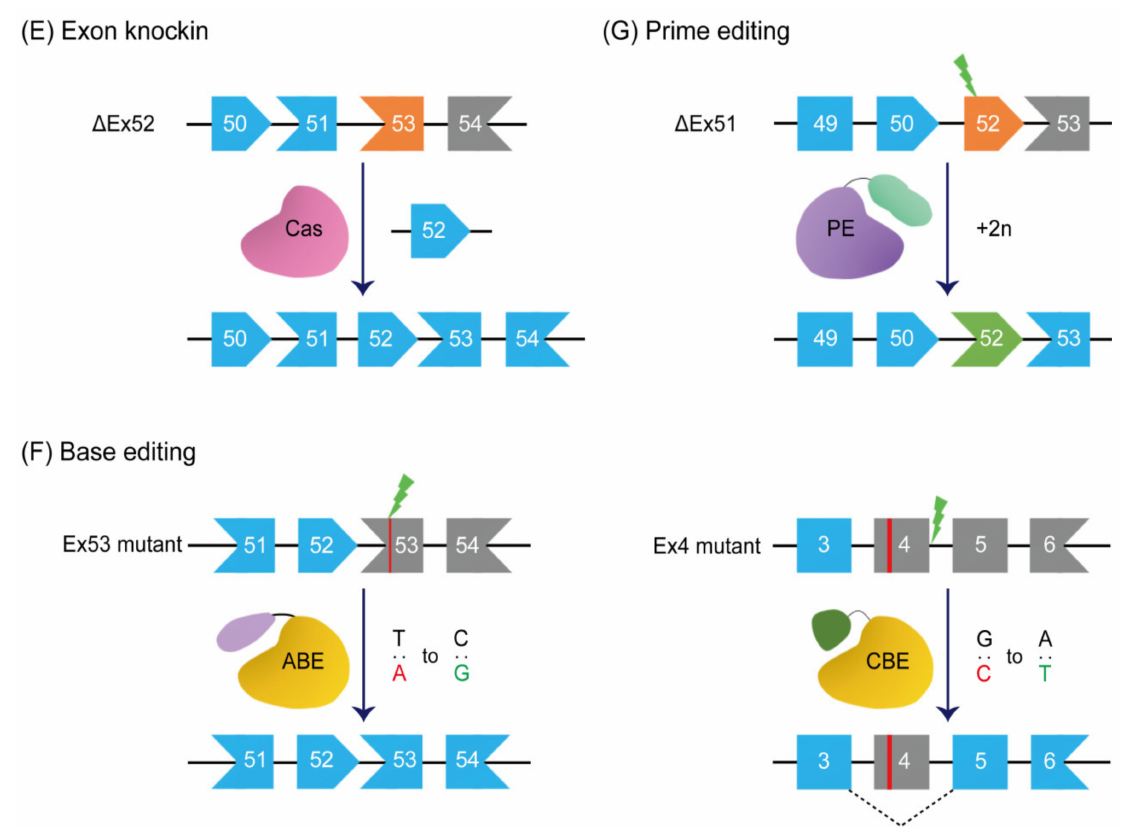
Figure 1. Therapeutic strategies for CRISPR-based genome editing. ( A ) Double-cut exon excision using two sgRNAs. In the end, exon 51 is removed from the genome by NHEJ machinery. ( B ) Single- cut exon skipping by disruption of the splice donor site. The exon 44 skipping induces the splicing of exon 42 to exon 45 at the mRNA level. ( C ) Single-cut exon reframing. Small insertions or deletions occurring in the exon 51 region can restore the reading frame with at least one-third